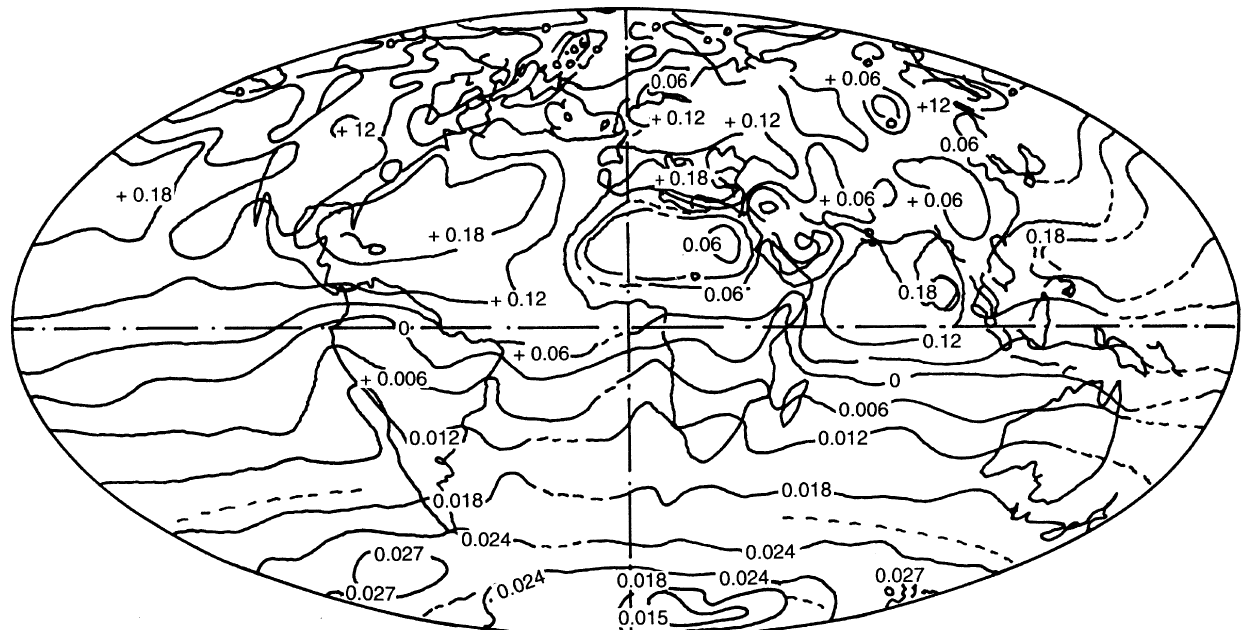
the net radiation flux ( (cid:93) 4.186 (cid:93) 10 (cid:52) ) at the top of the atmosphere in J · m (cid:126)(cid:50) · min